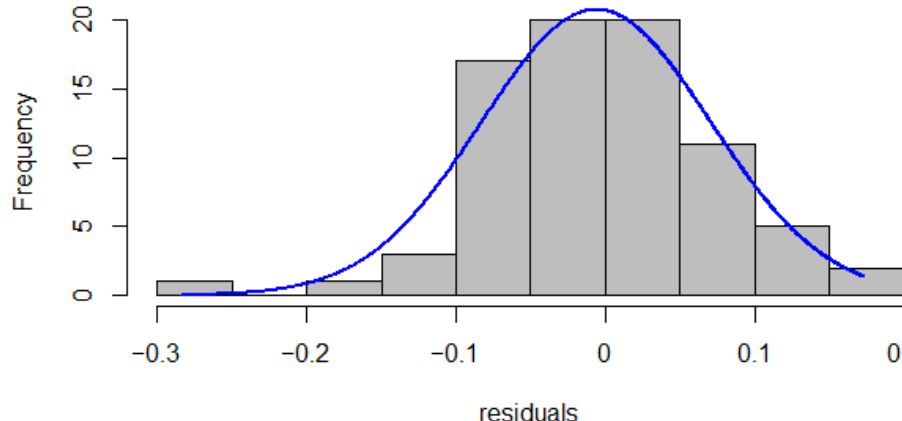
Figure A5. Histogram of residuals